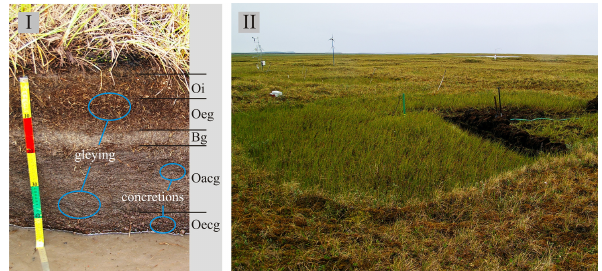
Figure 3. A “non-cryoturbated organic-dominated” permafrost- affected soil, Typic Historthel (I) and the study area it is from (II) – Samoylov Island, central Lena River Delta, Siberia 2007. Historthel , great group: Hist from histos , meaning tissue (plant); suborder: orth , from Orthels, which are soils with little or no cry- oturbation, and except for polygons, patterned ground is absent; or- der: el , formative element of Gelisols, from Latin gelu , meaning frost, coldness. “O” and “B” indicate soil horizons. “O” indicates an organic matter-dominated horizon that has formed at the soil surface. It consists of undecomposed or partially decomposed litter (i.e. needles, twigs, moss, and lichens). “B” indicates a subsurface horizon that has formed below an “O” or “A” horizon. It shows the obliteration of all or much of the parent soil material structure. It can be characterised by many qualifiers. Examples are gleying proper- ties (suffix “g”) described as formation of grey, greenish and bluish spots caused by reduced iron. Iron reduction occurs when soils are water-saturated for long periods. In this case, the soil parent mate- rial consists of fluvial sands that were deposited during a flood in the study area. Suffixes “i”, “e” and “a” classify the O horizon’s organic matter in “slightly”, intermediately” and “highly” decomposed. The existence of iron and/or manganese concretions is indicated by suf- fix “c”.